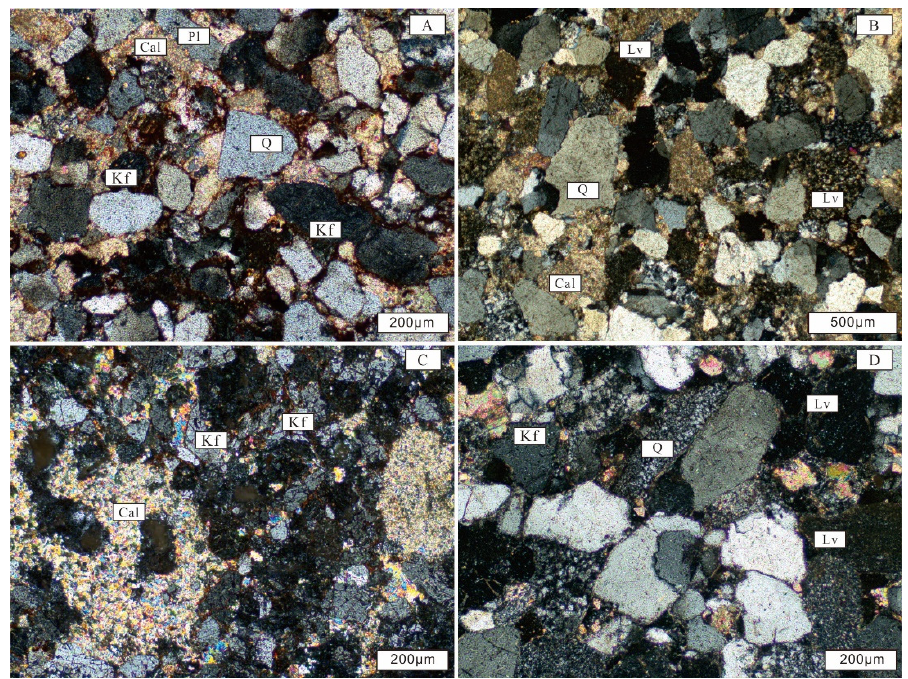
Figure 2. Photomicrographs of typical lithics in sandstones of the Jingxin Formation under cross- polarized light. ( A , B ), sample MP4 in section of Mangda. ( C , D ), sample MK11 in section of Mangkang. Abbreviations: Q, quartz; Cal, calcite; Pl, Plagioclase; Kf, K-Feldspar; Lv, volcanic rock fragment.